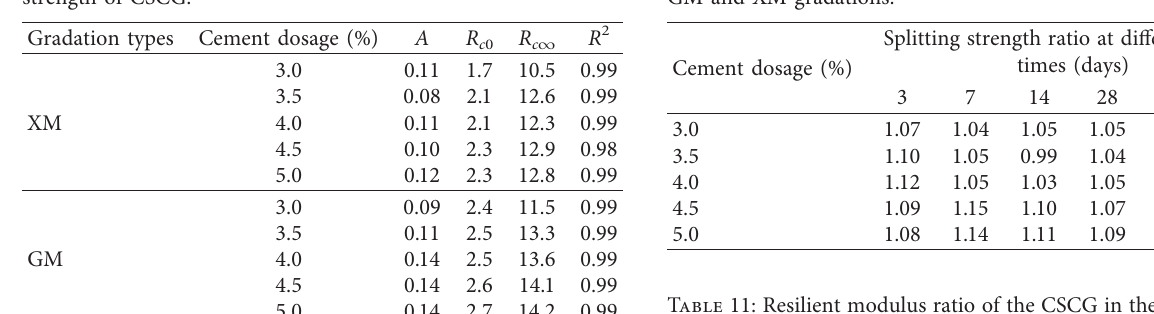
Table 6: Parameters of growth equation of unconfined compressive strength of CSCG.